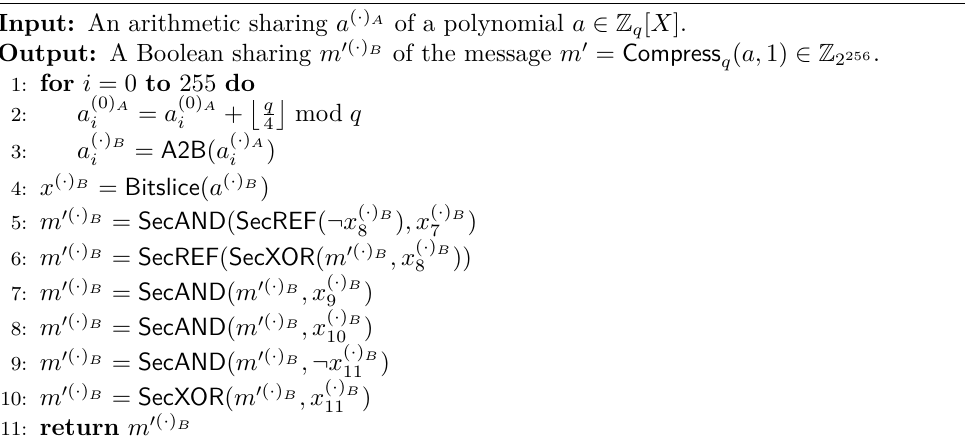
(cid:4) q (cid:5) ( x + mod q ) as used in q 4